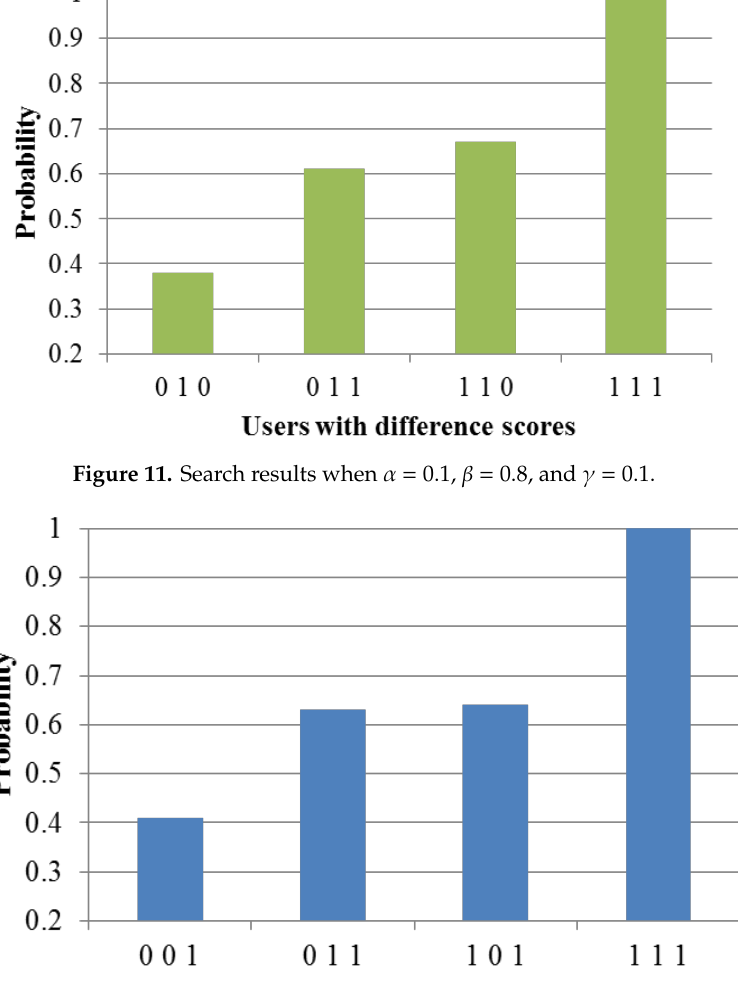
Figure 11. Search results when α = 0.1, β = 0.8, and γ = 0.1.